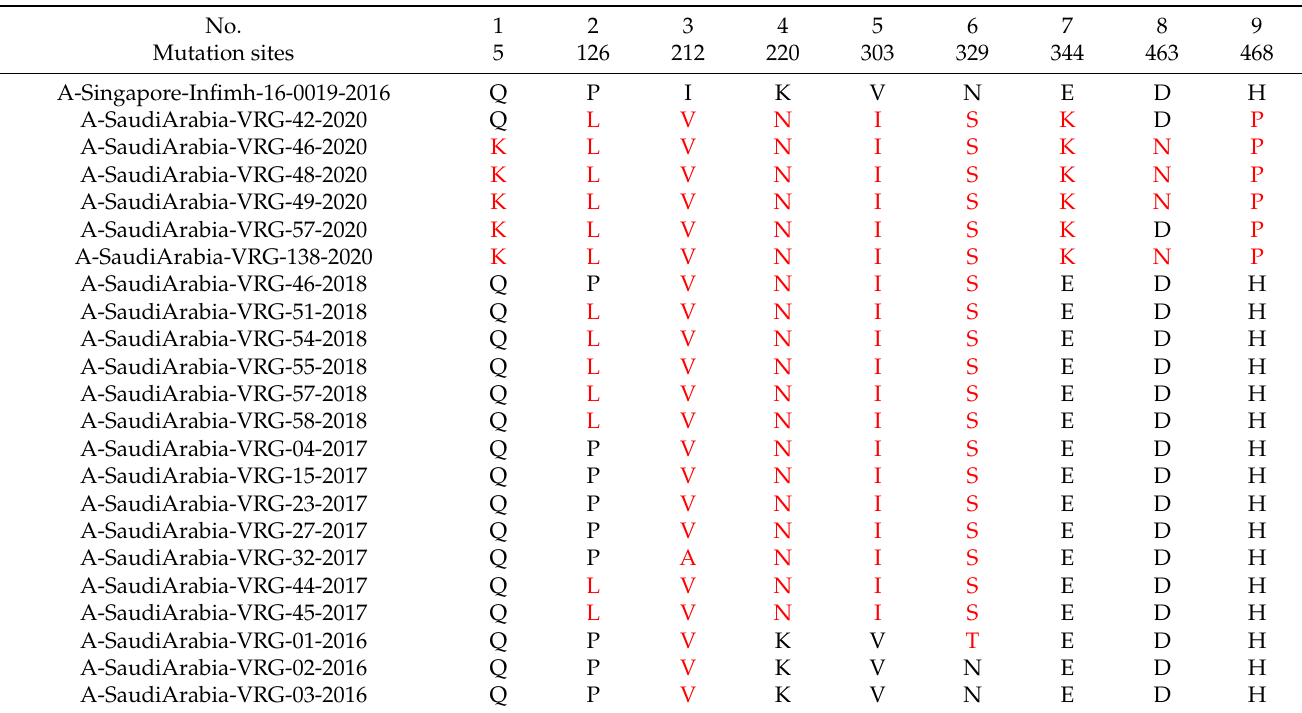
Table 3. Amino acid changes in the HA1 domain of Saudi H3N2 strains in comparison with the vaccine strain.